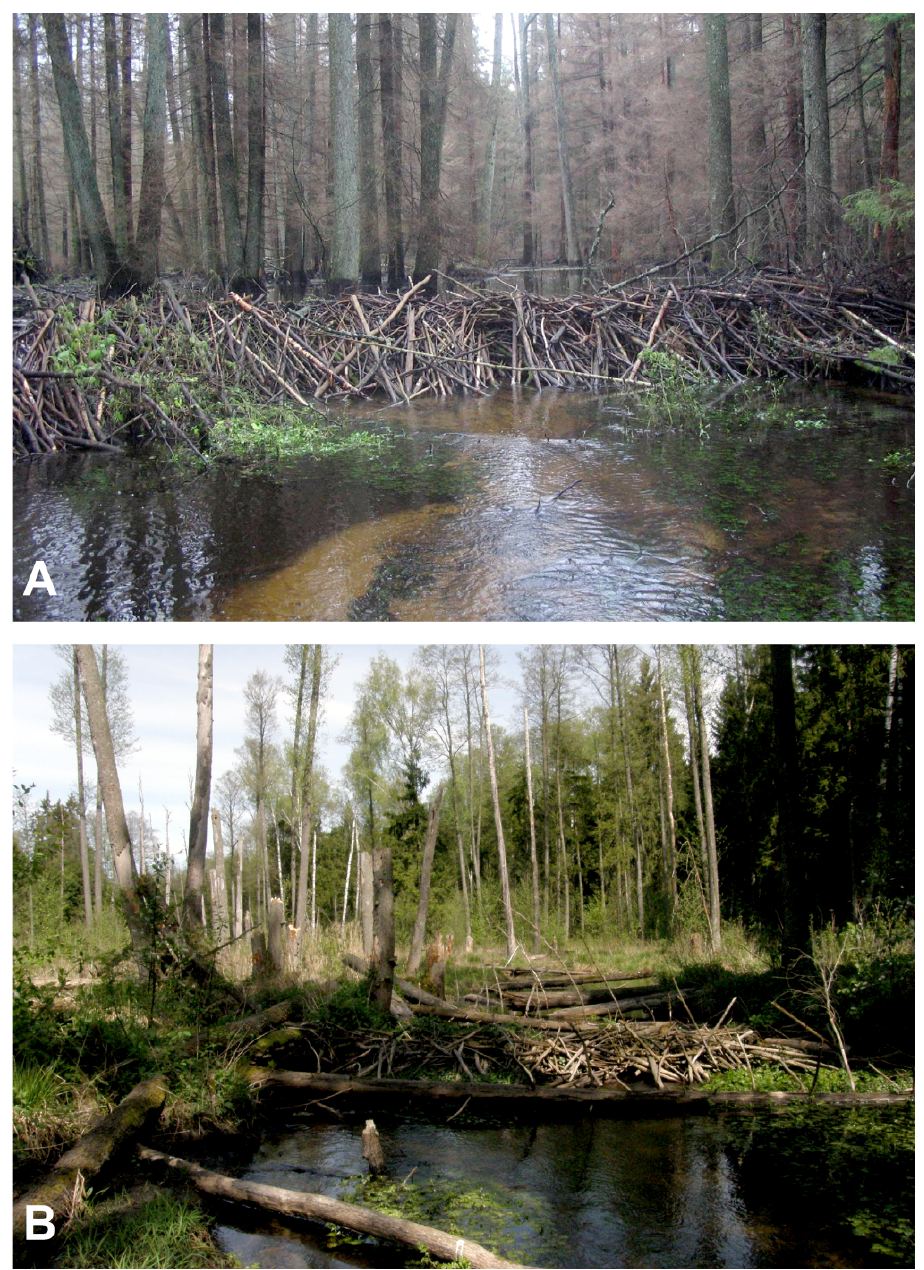
Figure 4. Landscape of the biggest beaver pond in the Krzemianka river valley in 2006 ( A ) and in 2013 ( B ). Pictures present views from the same position. Photo: Andrzej Grygoruk and Mateusz Grygoruk (Grygoruk, 2008